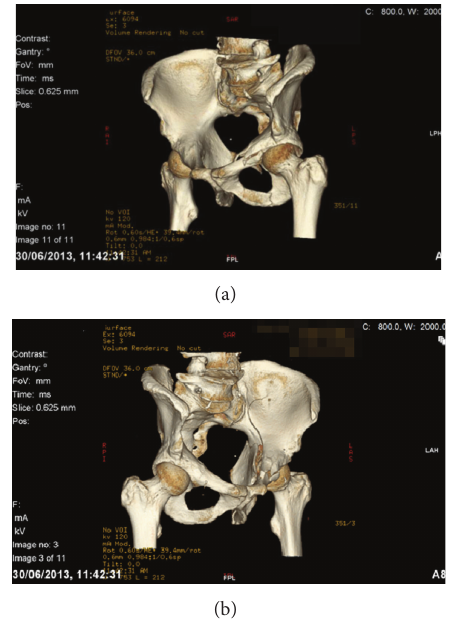
Figure 2: (a) An obturator oblique CT reconstruction. (b) An iliac oblique CT reconstruction.